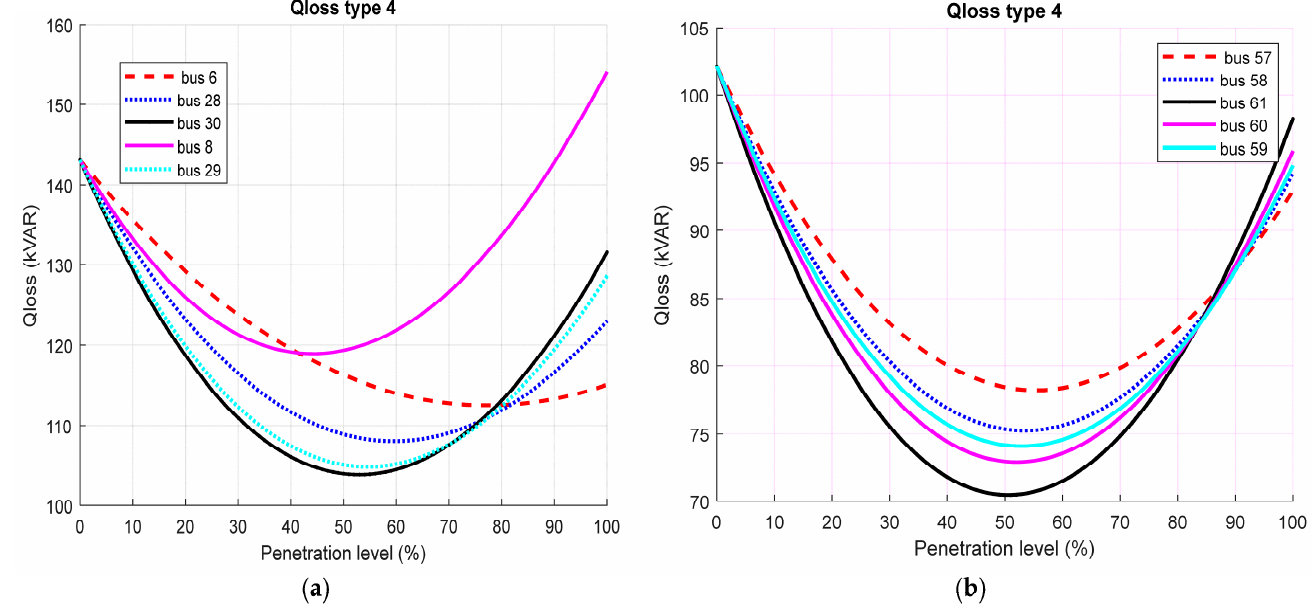
Figure 23. Qloss when Type 4 DG was interconnected to the selected nodes of IEEE ( a ) 33-bus ( b ) 69-bus RDNs.